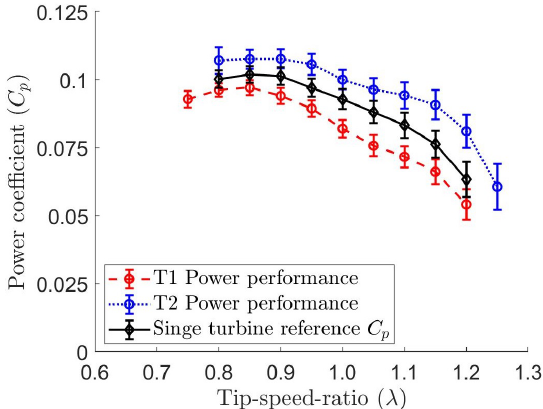
Figure 11. Power performance of turbine T1 and T2. The reference C p curve for the single turbine configuration was determined by averaging the power coefficient of T1 and T2 as a function of the tip-speed-ratio.